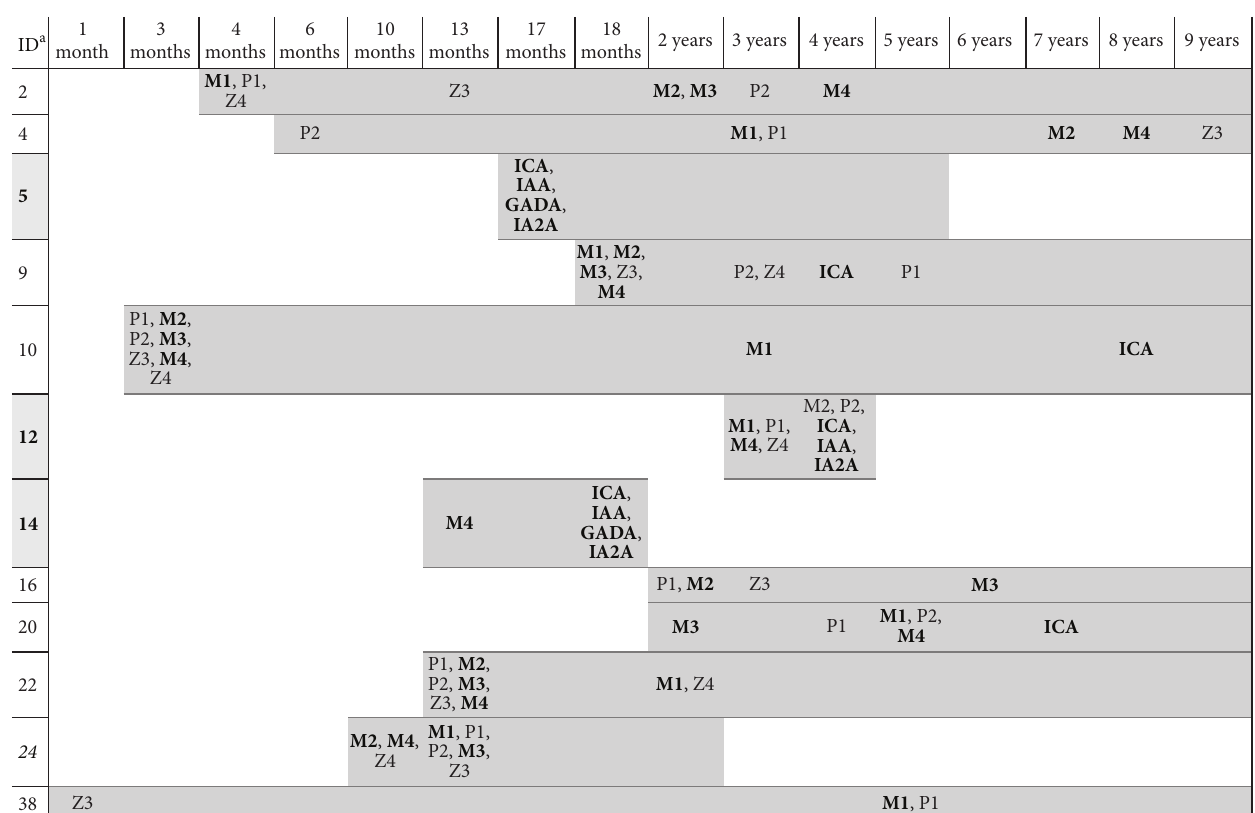
Figure 3: Age at detection of islet autoantibodies and immune reactivity to MAP, ZnT8, and PI homologous peptides in children at risk for T1D. Grey bars correspond to the time-point samples available for each child. a : identity of children positive for the studied peptides or/and islet autoantibodies ( 𝑛 = 11 ); highlighted patients progressed to T1D at 5, 4, and 1,5 years of age, respectively; patient indicated in italics was lost during the follow-up.